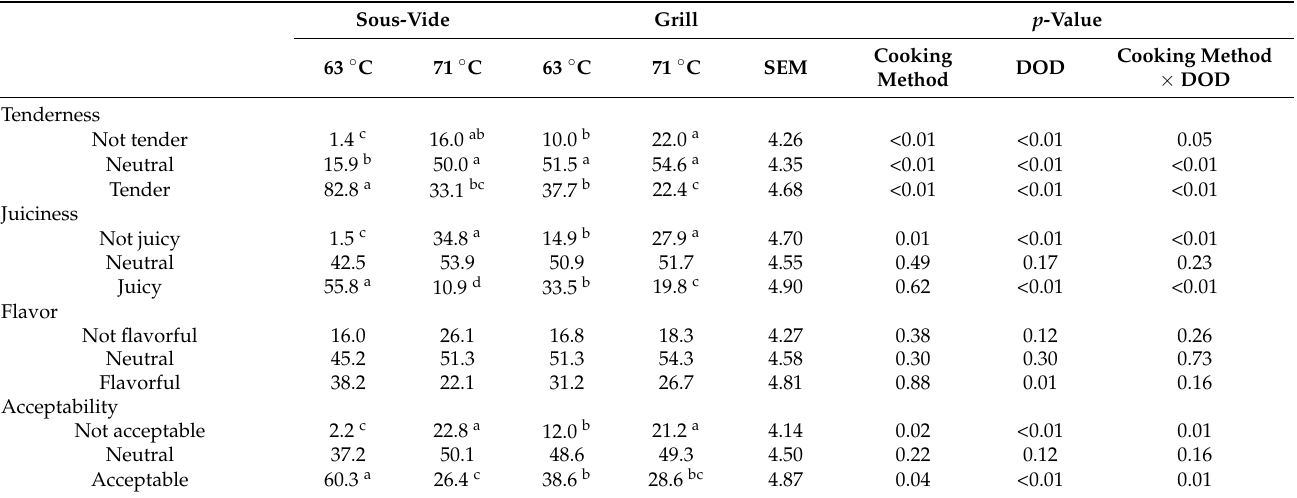
Table 4. Effects of cooking method and degree of doneness (DOD) on consumer sensory traits of pork chops 1,2